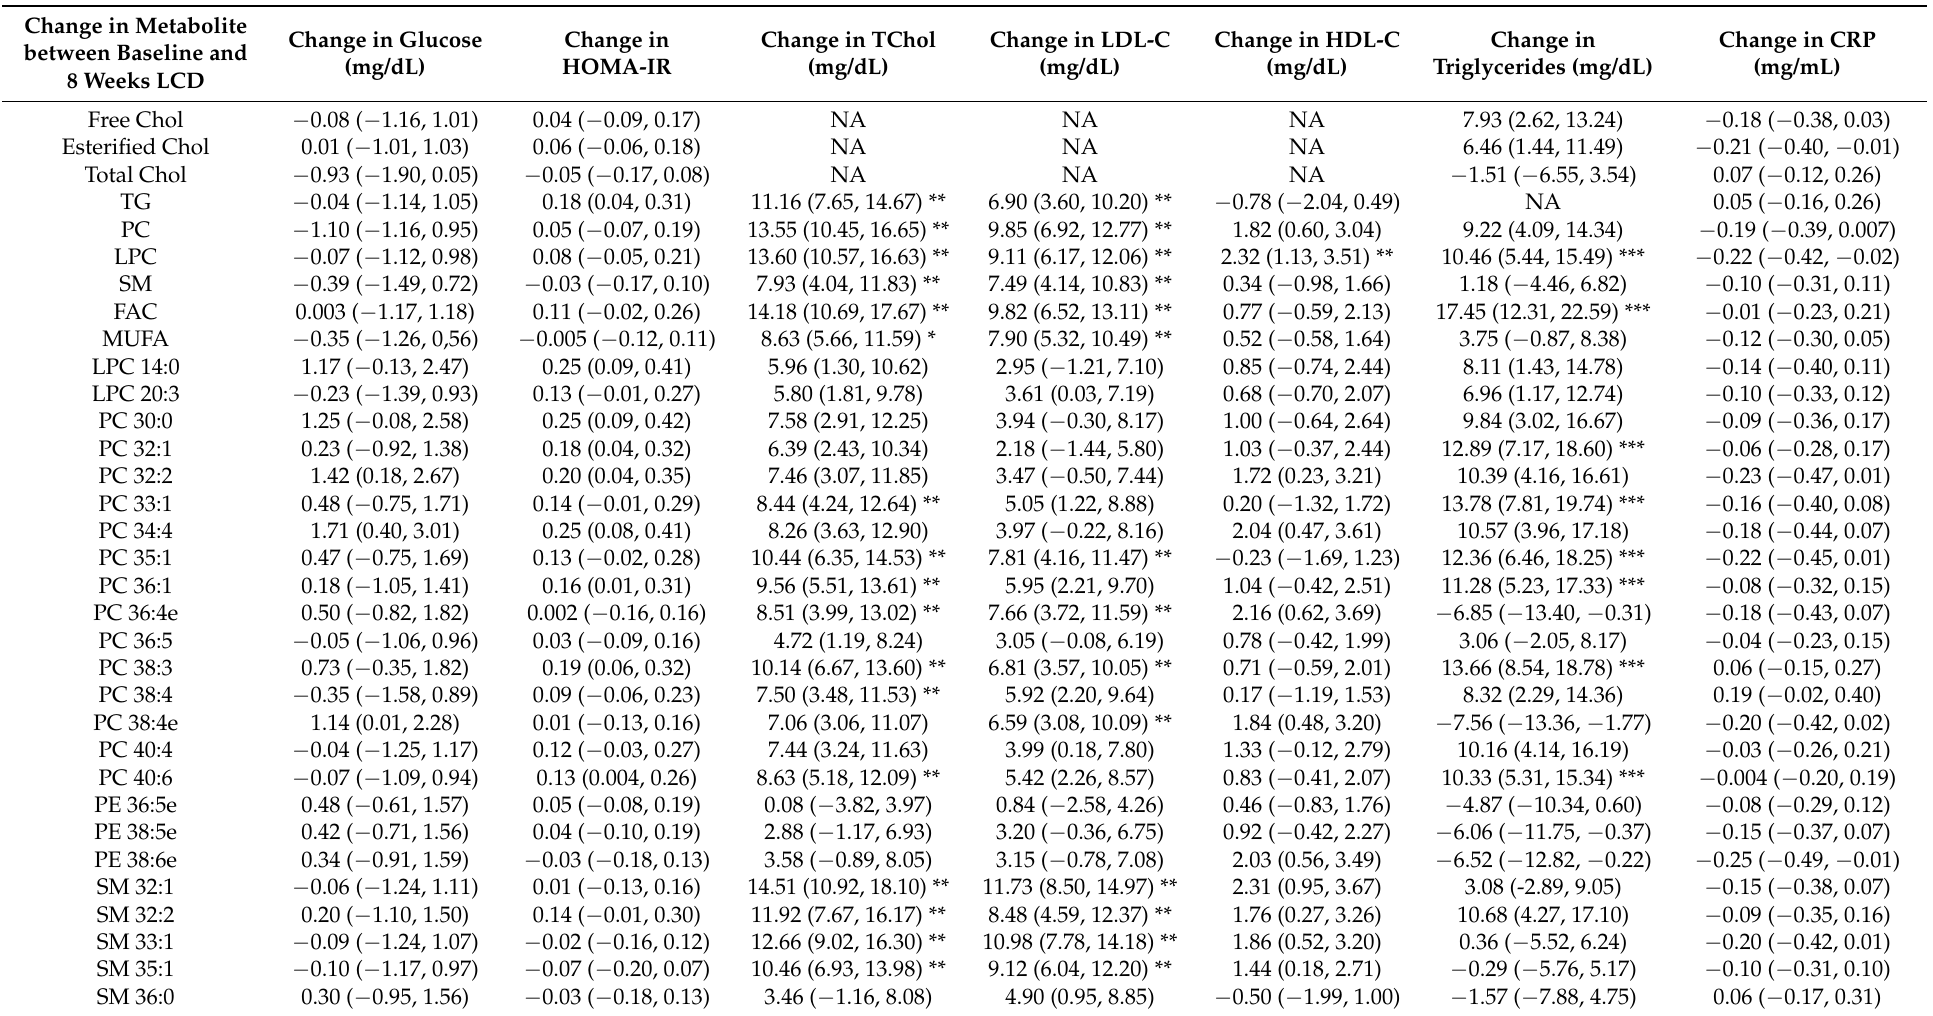
Table 2. Changes in cardiometabolic parameters at 8 weeks of a low-calorie diet (LCD) per 1SD log-transformed changes in the concentrations of metabolites. Change in Metabolite between Baseline